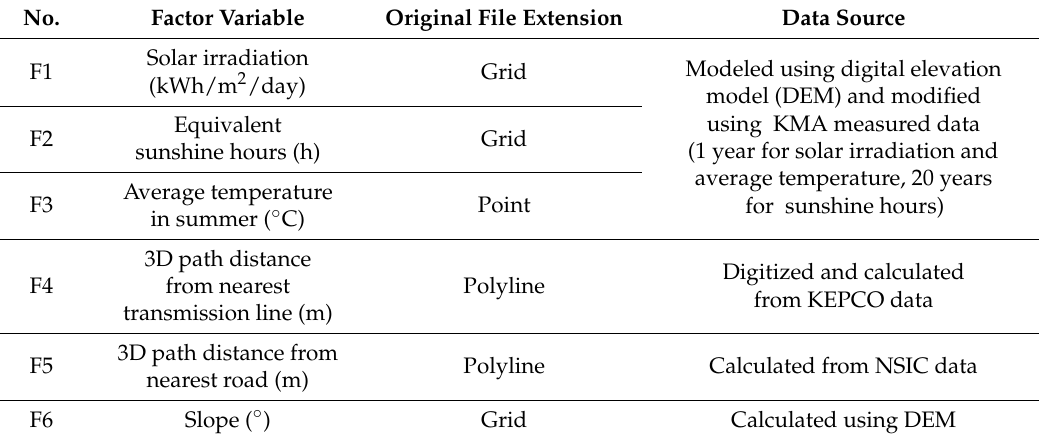
Table 3. List of factor variables, original data extension, and data source of the original data. KMA: Korea Meteorological Administration; and KEPCO: Korea Electric Power